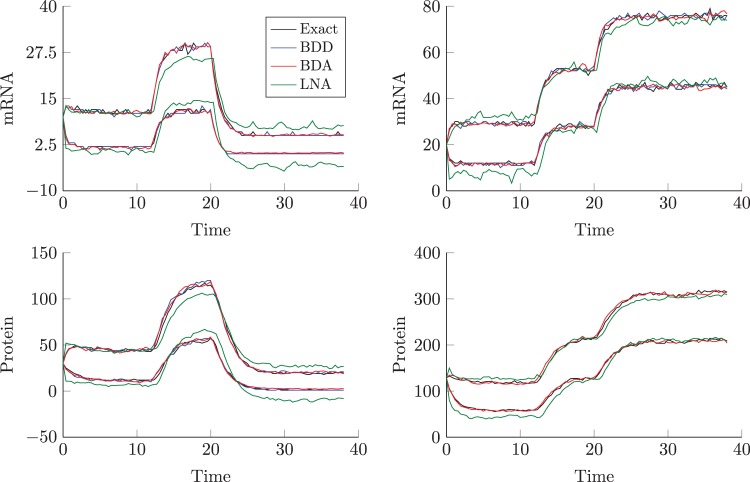
95% pointwise confidence envelopes for simulated mRNA (top) and protein (bottom) processes under the true process (black), the BDD (blue), the truncated normal BDA (red), and the LNA (green) for two different scenarios corresponding to different molecular abundances. Scenario 1 (left) is simulated from the parameters \documentclass[12pt]{minimal}
\usepackage{amsmath}
\usepackage{wasysym}
\usepackage{amsfonts}
\usepackage{amssymb}
\usepackage{amsbsy}
\usepackage{upgreek}
\usepackage{mathrsfs}
\setlength{\oddsidemargin}{-69pt}
\begin{document}
}{}$\delta _m=1, \delta _p=0.7$\end{document}, \documentclass[12pt]{minimal}
\usepackage{amsmath}
\usepackage{wasysym}
\usepackage{amsfonts}
\usepackage{amssymb}
\usepackage{amsbsy}
\usepackage{upgreek}
\usepackage{mathrsfs}
\setlength{\oddsidemargin}{-69pt}
\begin{document}
}{}$\alpha =3, \beta _0=6, \beta _1=20, \beta _2=2$\end{document} with switches occurring at \documentclass[12pt]{minimal}
\usepackage{amsmath}
\usepackage{wasysym}
\usepackage{amsfonts}
\usepackage{amssymb}
\usepackage{amsbsy}
\usepackage{upgreek}
\usepackage{mathrsfs}
\setlength{\oddsidemargin}{-69pt}
\begin{document}
}{}$t=12, 20$\end{document}. Scenario 2 (right) is simulated with parameters \documentclass[12pt]{minimal}
\usepackage{amsmath}
\usepackage{wasysym}
\usepackage{amsfonts}
\usepackage{amssymb}
\usepackage{amsbsy}
\usepackage{upgreek}
\usepackage{mathrsfs}
\setlength{\oddsidemargin}{-69pt}
\begin{document}
}{}$\delta _m=1, \delta _p=0.7, \alpha =3,\beta _0=20, \beta _1=40, \beta _2=60$\end{document} with switches occurring at \documentclass[12pt]{minimal}
\usepackage{amsmath}
\usepackage{wasysym}
\usepackage{amsfonts}
\usepackage{amssymb}
\usepackage{amsbsy}
\usepackage{upgreek}
\usepackage{mathrsfs}
\setlength{\oddsidemargin}{-69pt}
\begin{document}
}{}$t=12, 20$\end{document}.